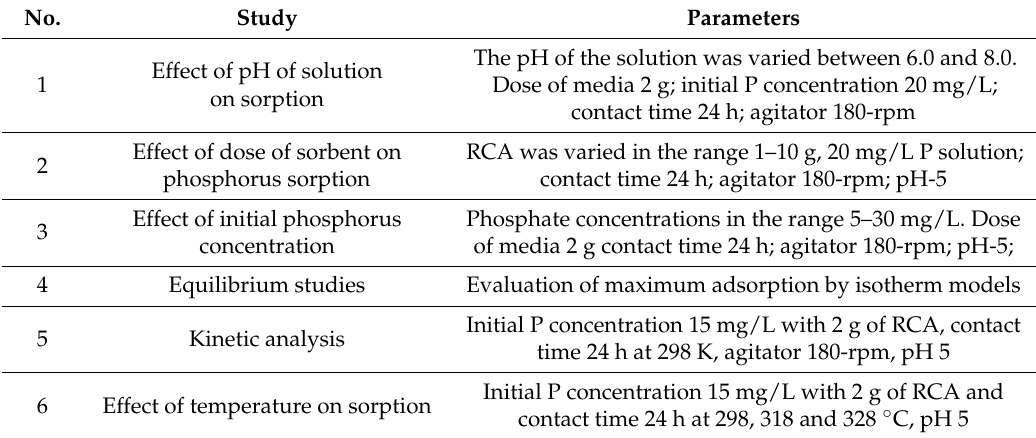
Table 1. Experimental schedule for the adsorption of